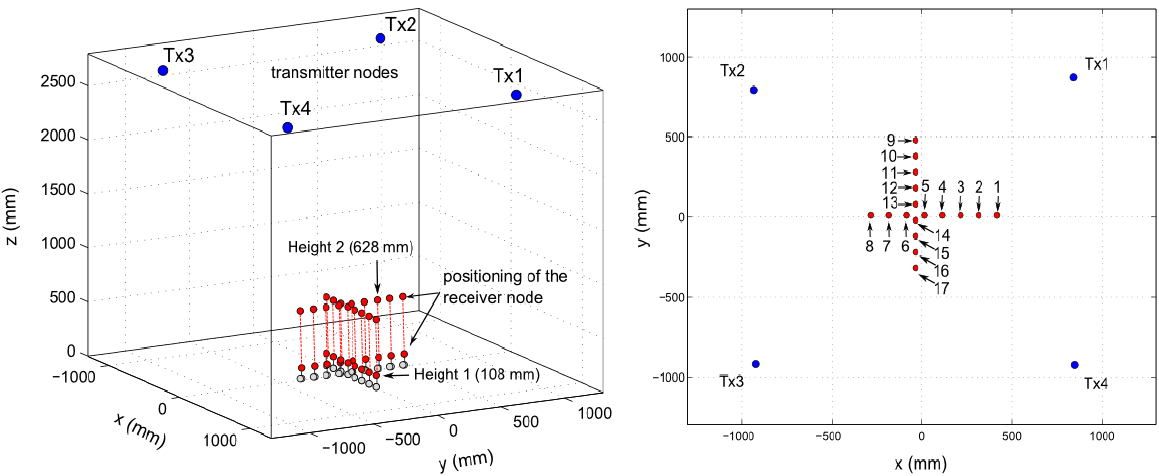
Figure 12. (Left) Illustration of the node position in the 3D-space. The red dots show the position of the receiver node on the optical bench. Positioning measurements are taken at two different heights (10.8 cm and 62.8 cm). (Right) Illustration of the node position in the 2D-space. The blue dots are the position of the transmitter nodes projected onto the xy-plane. The red dots are the positions of the receiver node in its displacement on the optical